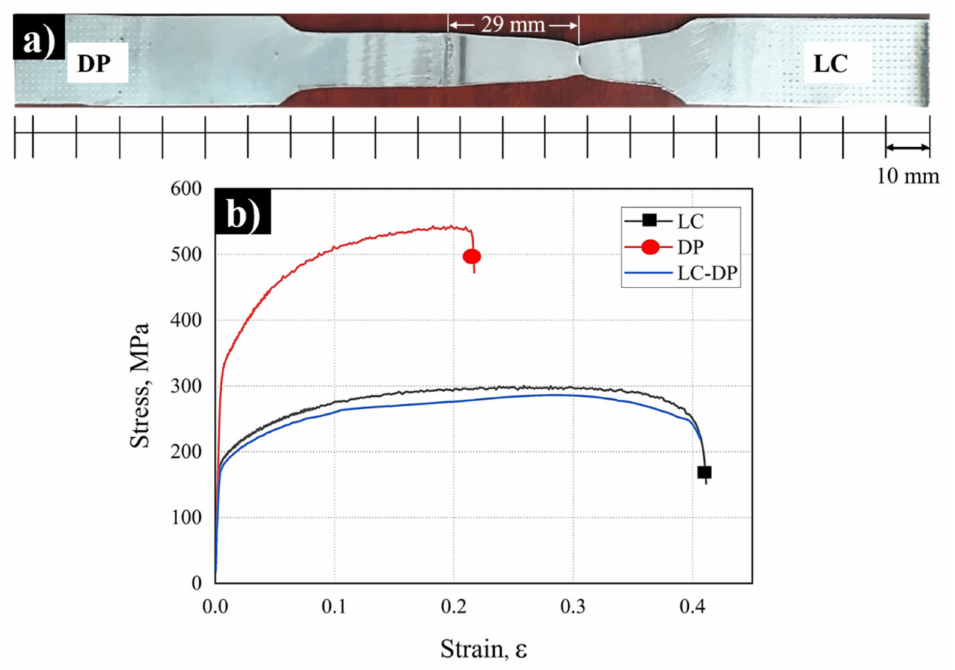
Figure 15. ( a ) Tensile fracture in the LC–DP dissimilar welding and ( b ) stress-strain behavior for the base metals and the LC–DP dissimilar welding.